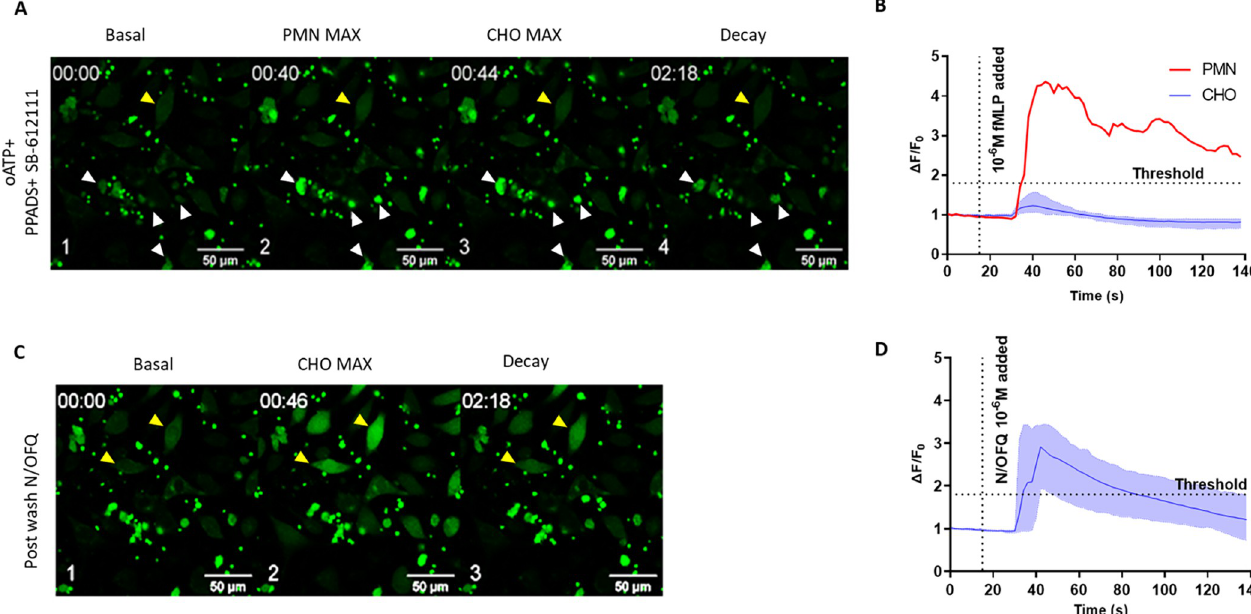
Fig 6. CHO hNOPG α qi5 colayered with PMNs stimulated with fMLP 10 -6 M in the presence of PPADS, oATP and SB-612111 do not increase calcium. A. Representative photomicrograph (from n = 6) showing 1. Basal, 2. Maximal PMN, 3. Maximal CHO stimulation in response to 1x10 -6 M fMLP in the presence of PPADS, oATP and SB-612111 measured by confocal microscopy using FLUO-4 as an indicator dye. PMNs are identified by white arrows, while CHO hNOPG α qi5 are identified by yellow arrows. B shows corresponding Δ F/F 0 over time; shaded areas denote minimal and maximal response for the cell population. C. Representative photomicrograph (from n = 6) showing 1. Basal, 2. Maximal CHO stimulation in response to N/OFQ 1 x10 -6 M in the absence of antagonists. D shows corresponding Δ F/F 0 over time and return of N/OFQ response; shaded areas denote minimal and maximal response for the cell population.